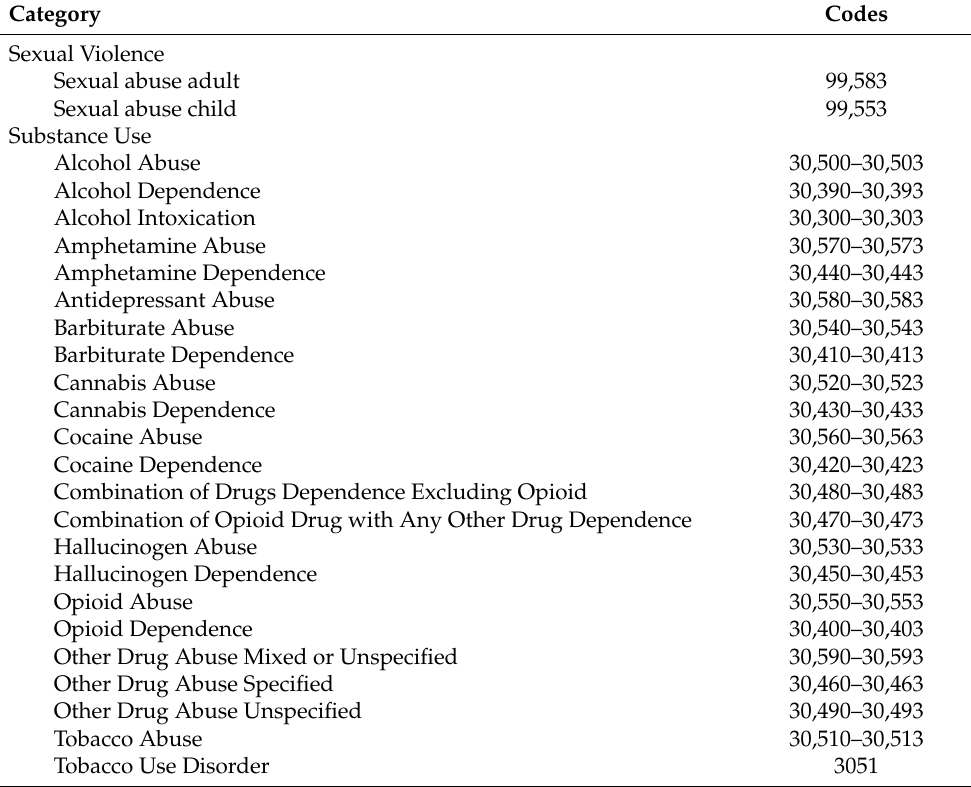
Table 1. ICD-9 Codes for Sexual Violence and Substance Use: HCUP Emergency Department Visit Database for Hawaii,